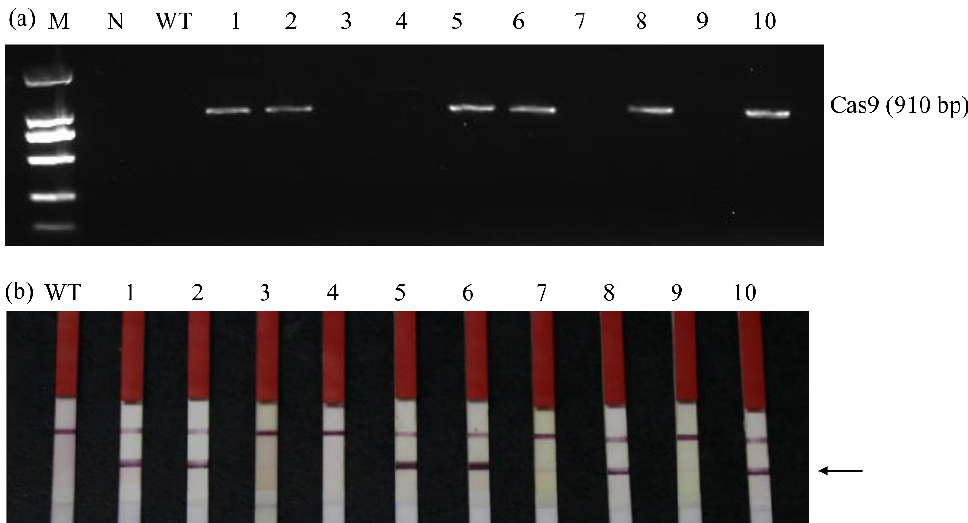
Figure 3. Identifying “transgene-free” mutant soybean lines of fad2-1afad2-1b. ( a ) PCR method to detect a partial sequence that encoded the Cas9 protein with an expected PCR product of 910 bp. M represents the marker, N represents the negative control, WT represents the wild type, and Lanes 1-10 are the respective tested transgenic lines. ( b ) The bar strip test to detect transgenic elements. The arrow indicates that the bar was positive for the presence of the transgene. Table 3. The fad2-1a / fad2-1b mutants without transgenic elements in the T3 and T4 generations. fad2-1a / fad2-1b Mutant